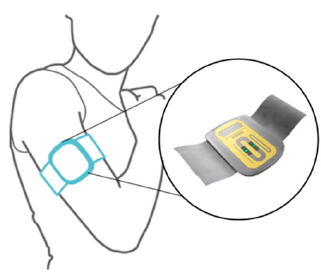
Figure 1. The Multisensor system worn on the upper arm and schematic illustration of its substrate.